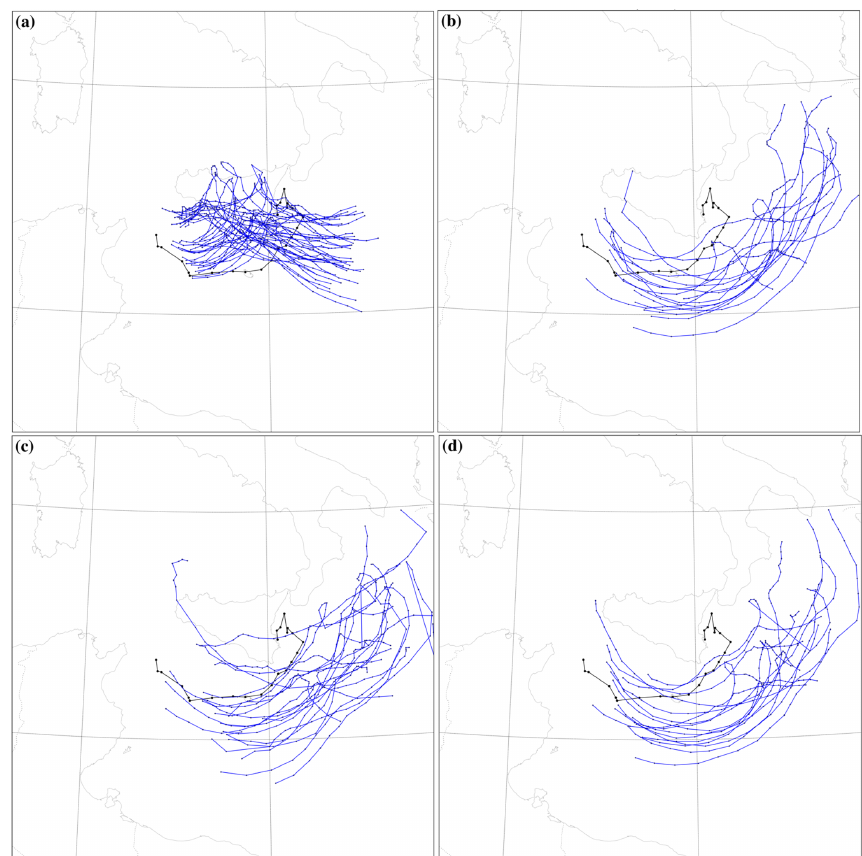
Figure 10. Trajectory of cyclones generated by each ensemble member (solid blue lines) by the (a) NODA, (b) SYN, (c) RSAMV and (d) CNTRL experiments from 11:00UTC, 7 November, to 12:00UTC, 8 November 2014. Solid black lines depict the trajectory of the medicane observed from satellite